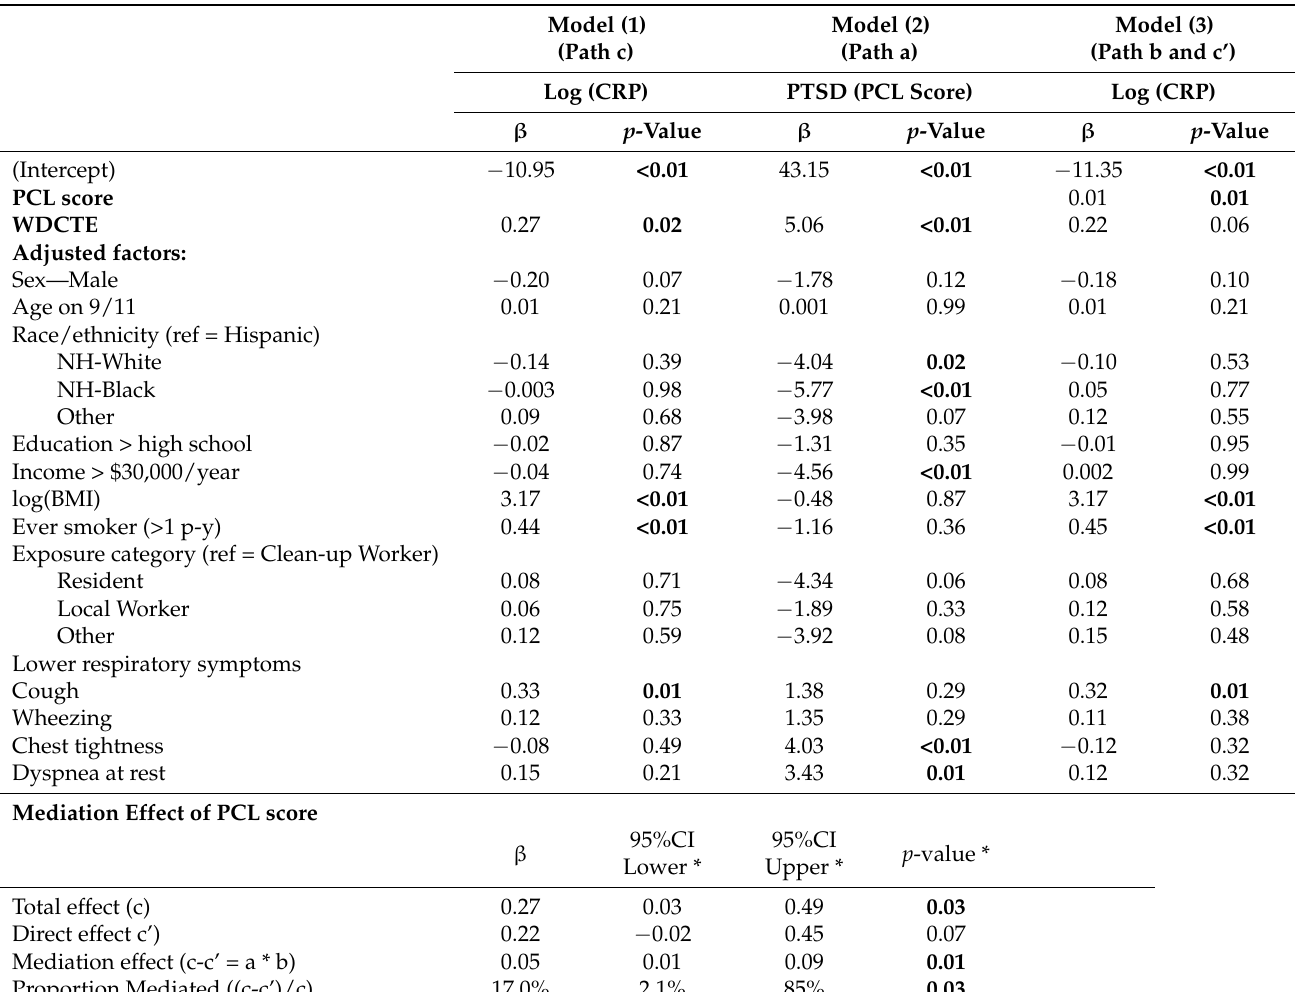
Table 3. Multiple linear regression models for assessing mediation effect of PTSD (PCL score) in the association of WDCTE and CRP level (log(CRP)), adjusted for demographic characteristics and lower respiratory symptoms ( n = 731).